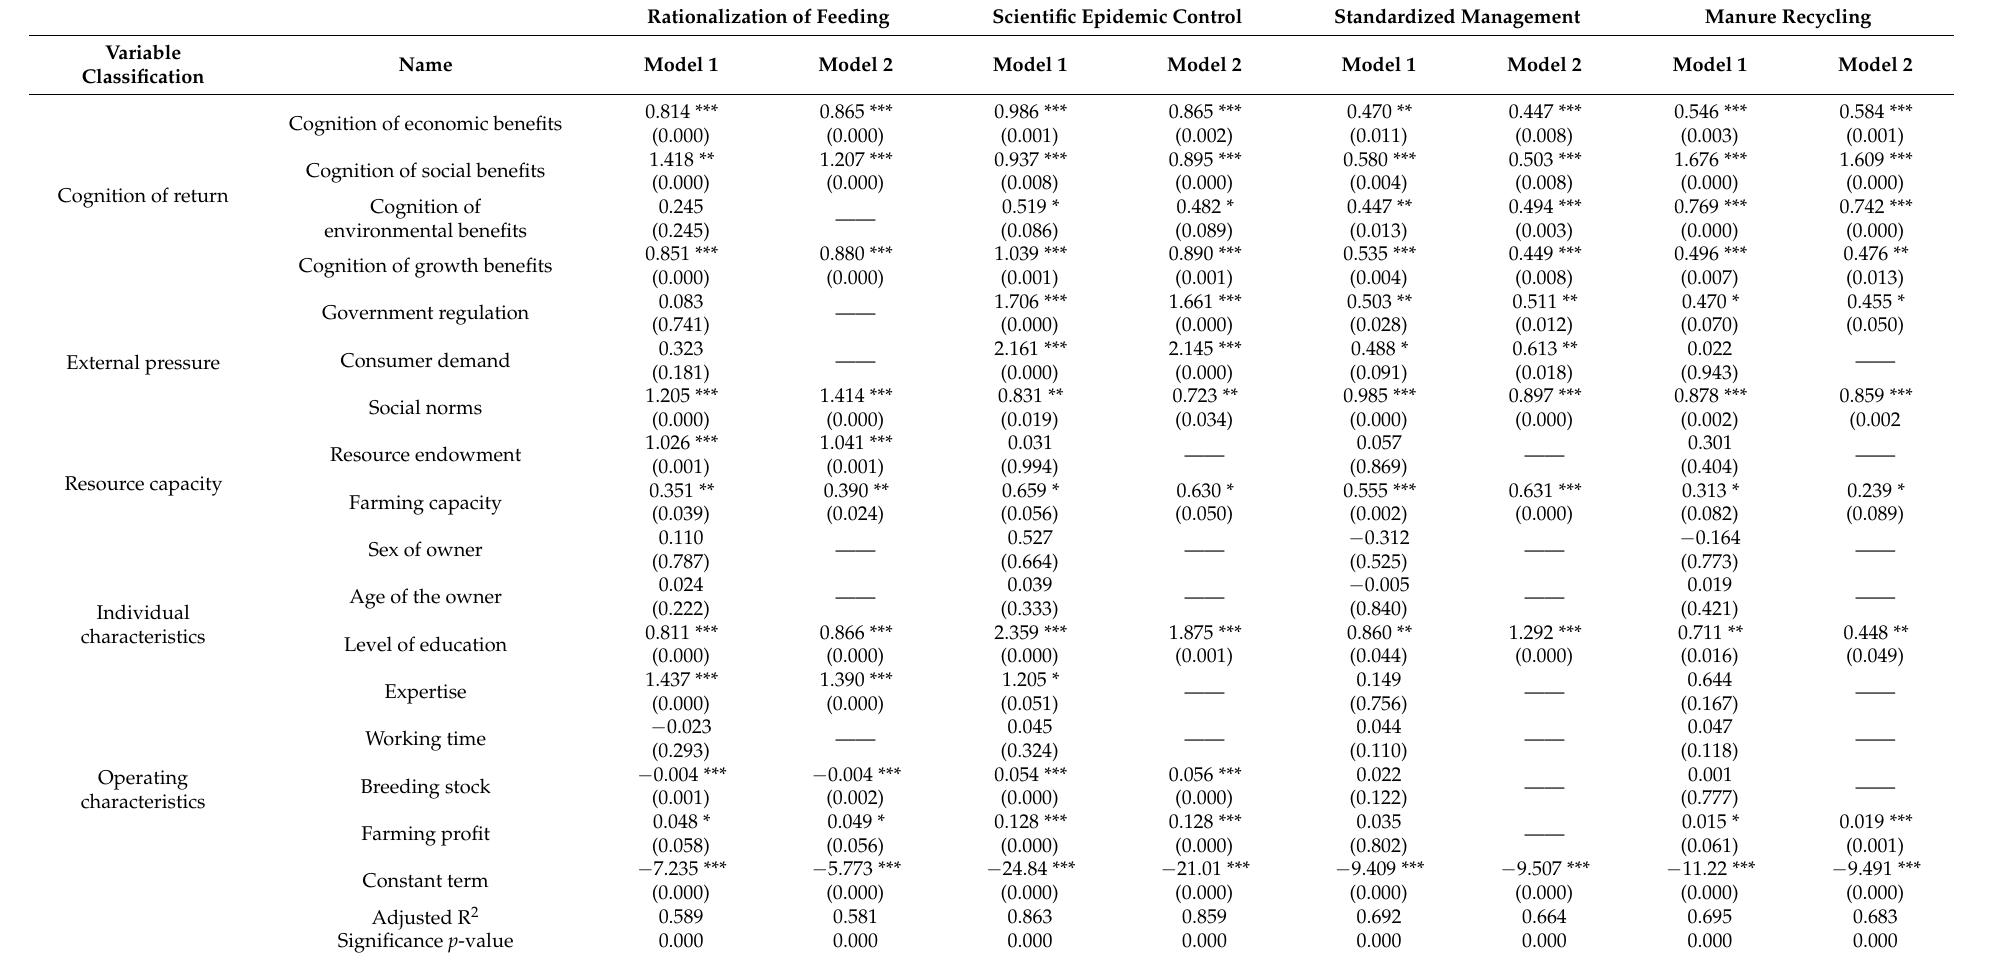
Table 4. Regression Results of Influencing Factors of Different Green Production Behaviors of Pig